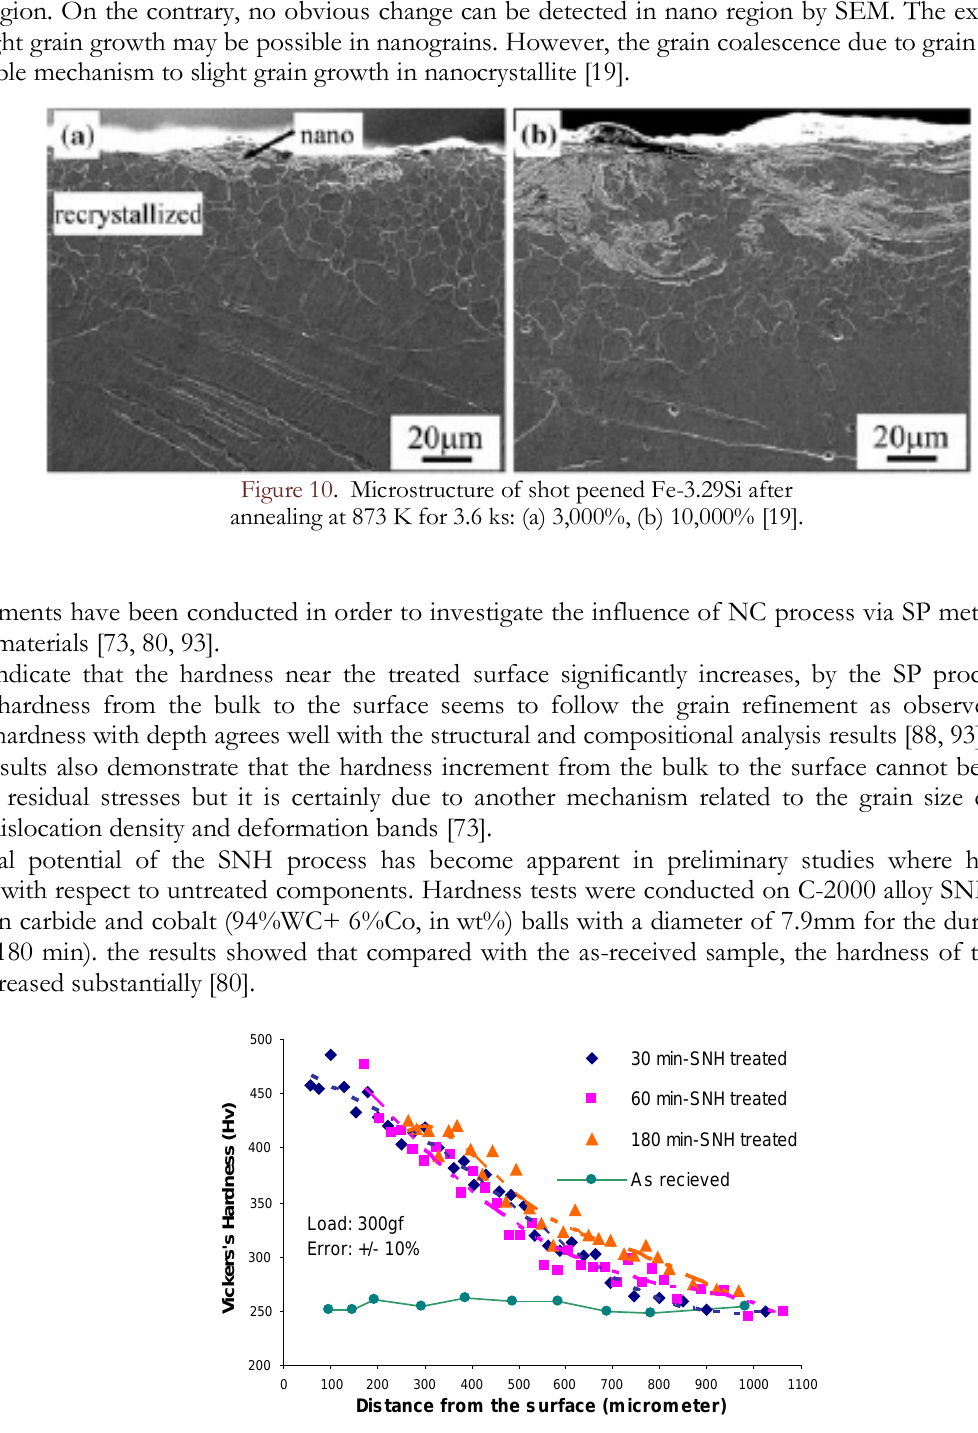
Figure 11: Hardness profile of the samples